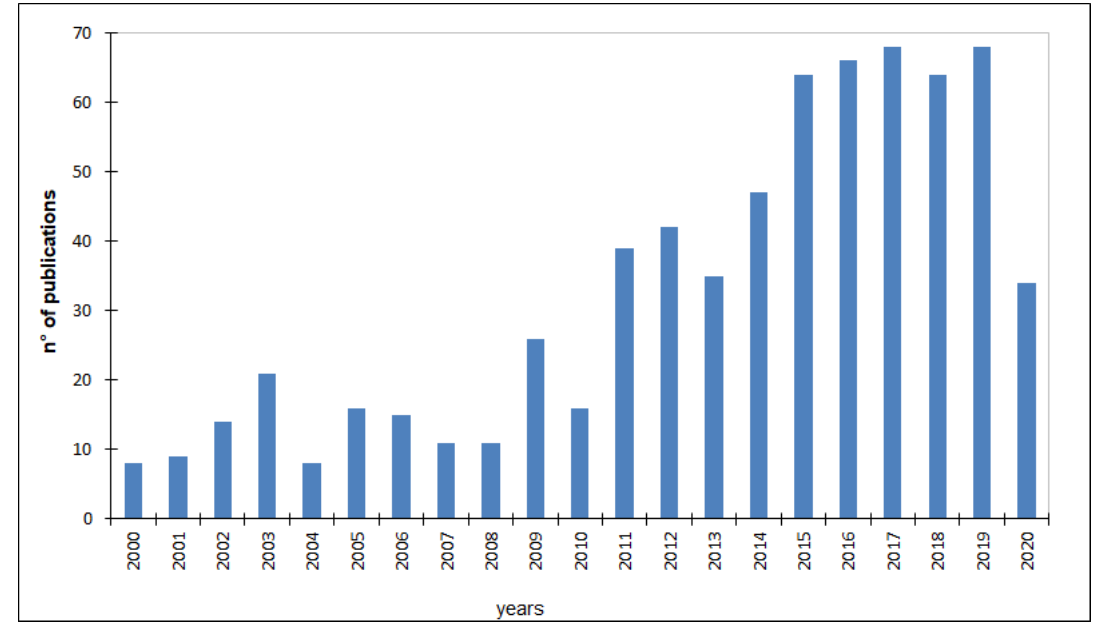
Figure 1. Trend of soil microbial inoculants application publications from 2000 to 2020. The histogram represents the number of the papers per year.